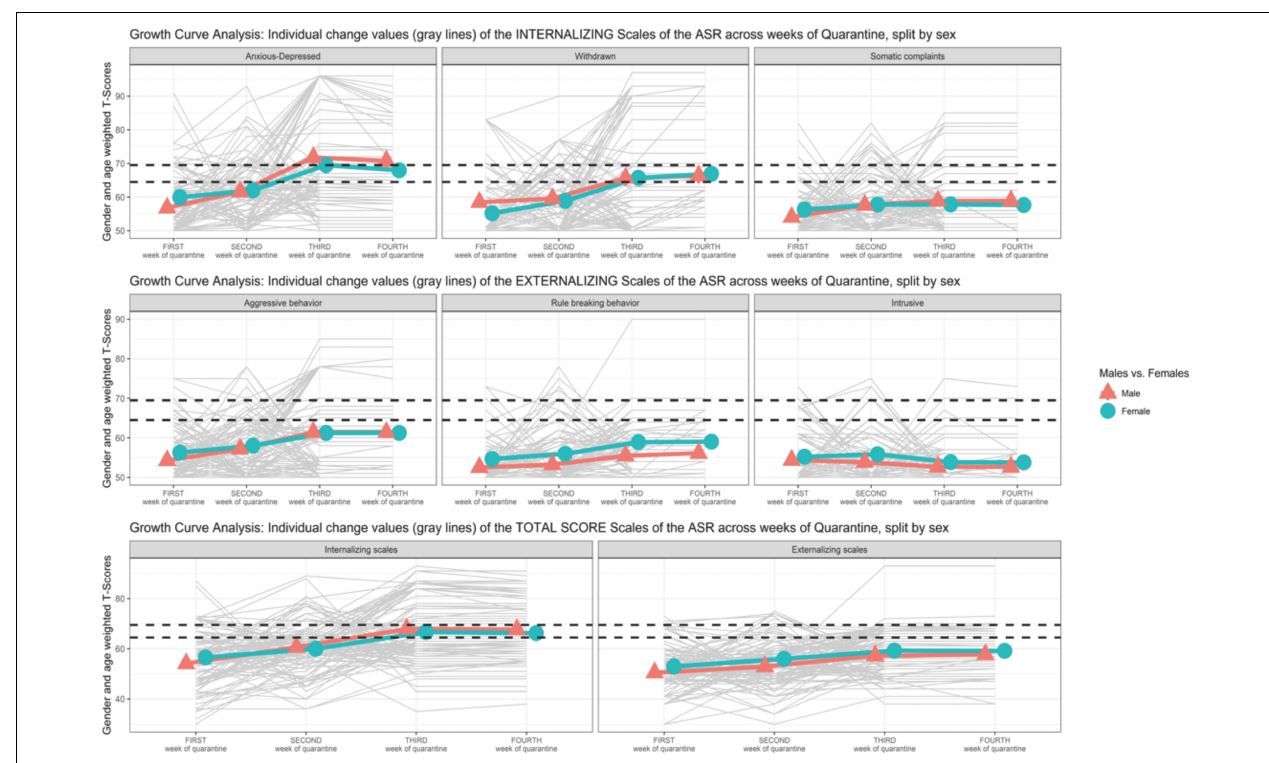
FIGURE 3 | Growth curve analysis (GCA): means and standard error of the Syndromic Scale across weeks of quarantine split by sex.